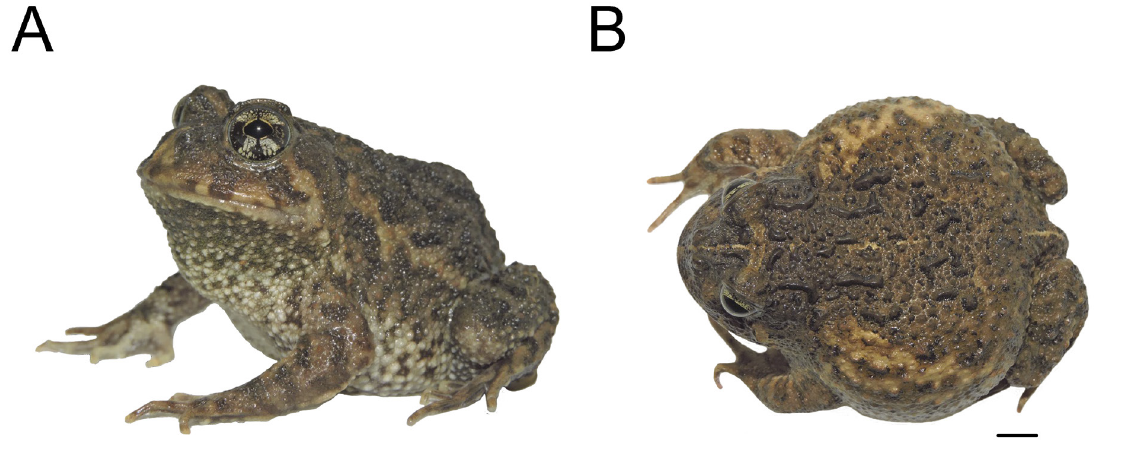
Fig. 2. Odontophrynus toledoi sp. nov., holotype, ♂ (ZUEC-AMP 24833), in life. A . Lateral view. B . Dorsal view. Scale bar = 5